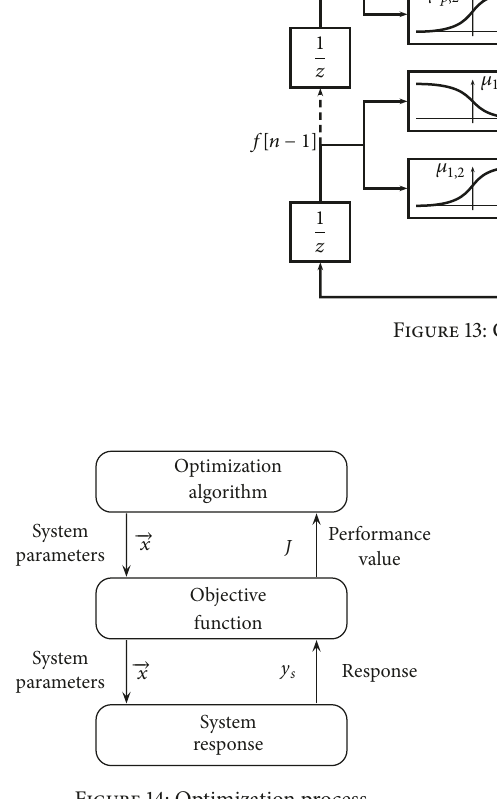
Figure 14: Optimization